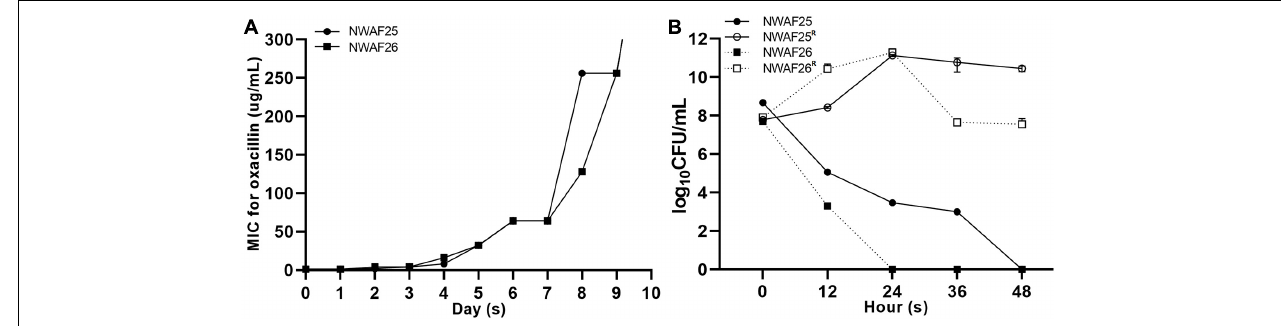
FIGURE 1 | Oxacillin susceptibility assay of Staphylococcus sciuri. (A) Minimal inhibitory concentration (MIC) of oxacillin in S. sciuri NWAF25, NWAF26, and their oxacillin-induced derivations, starting from the 0 generation to the 10th generation. (B) Bactericidal time with a survival rate of 1% (MDK99) in S. sciuri and their derivatives. The survival rate of isolates grown in tryptic soy broth (TSB) medium at 37 ◦ C with 20 mg/L oxacillin was calculated at five time points (0, 12, 24, 36, and 48 h). Solid circle and solid square represent wild-type isolates NWAF25 and NWAF26, respectively; while hollow circle and hollow square represent the corresponding derivatives of NWAF25 and NWAF26 at 10th generation, respectively. Data are represented as means ± S.D. (error bars) from three independent experiments.